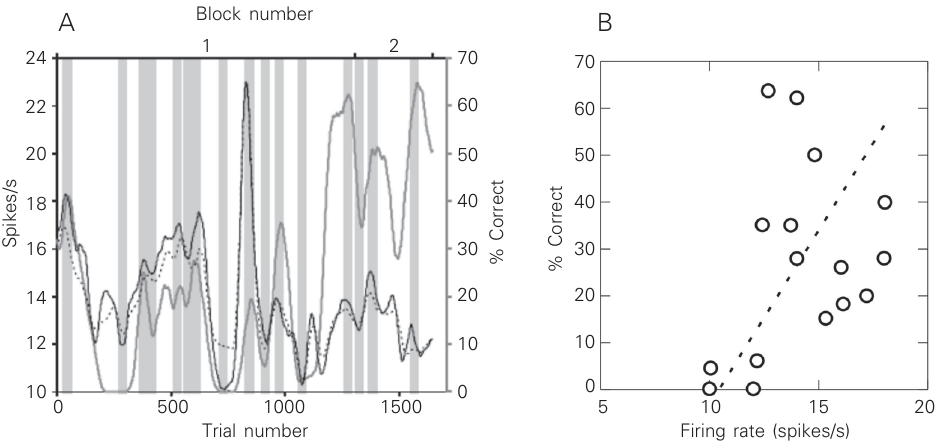
Figure 1. A , Activity of a perirhinal neuron whose firing rate shows a direct correlation with the monkey’s behavioral performance. Smoothed firing rate and percent correct performance are plotted against trial and block number. The continuous and dotted black lines indicate the spontaneous and whole-trial activity, respectively, with the scale on the left vertical axis in spikes per second. The continuous gray line indicates the monkey’s behavioral performance with the scale on the right vertical axis, as % correct. All three curves were Gaussian smoothed using the same sliding window. Vertical gray bars, whose width corresponds to approximately 25 trials, were positioned to indicate the coincidence of peaks or troughs between neuronal activity and behavioral performance. Observe the coincidence between these two parameters at the position of the peaks and troughs, independent of their amplitude. The whole trial firing rate and the spontaneous activity correlated in the same way with behavioral performance. B , Lack of correlation (P = 0.67) between neuronal activity (spike rate) and behavioral performance (% correct). The dashed line represents the regression line determined by the least square